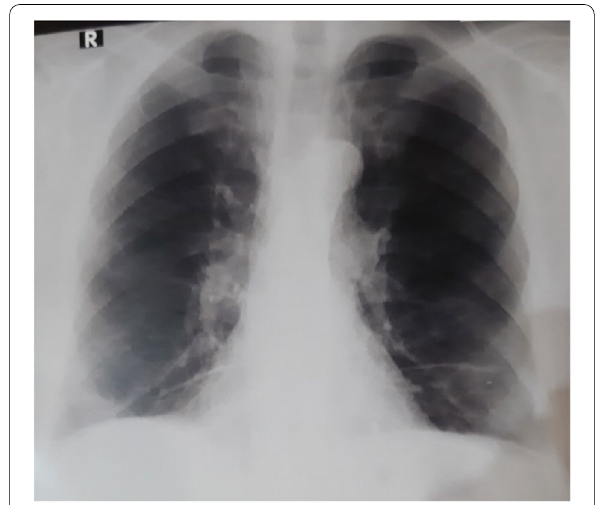
Fig. 3 Chest X-ray showing basal opacities in bilateral bands confirmed at the chest CT level